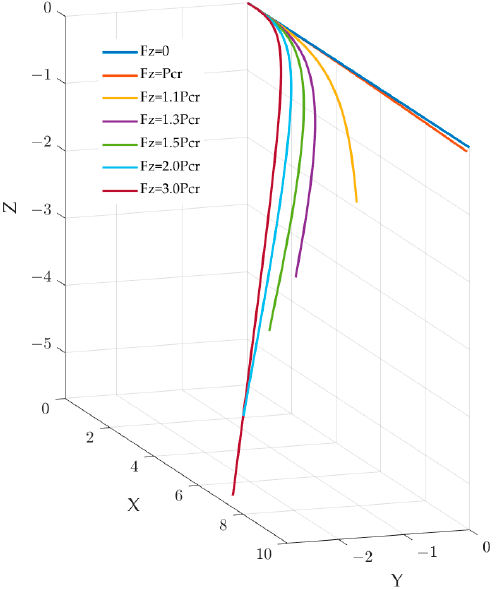
Figure 11. The deformation processes of the cantilever beam with a downward concentrated load up to 3 Pcr.